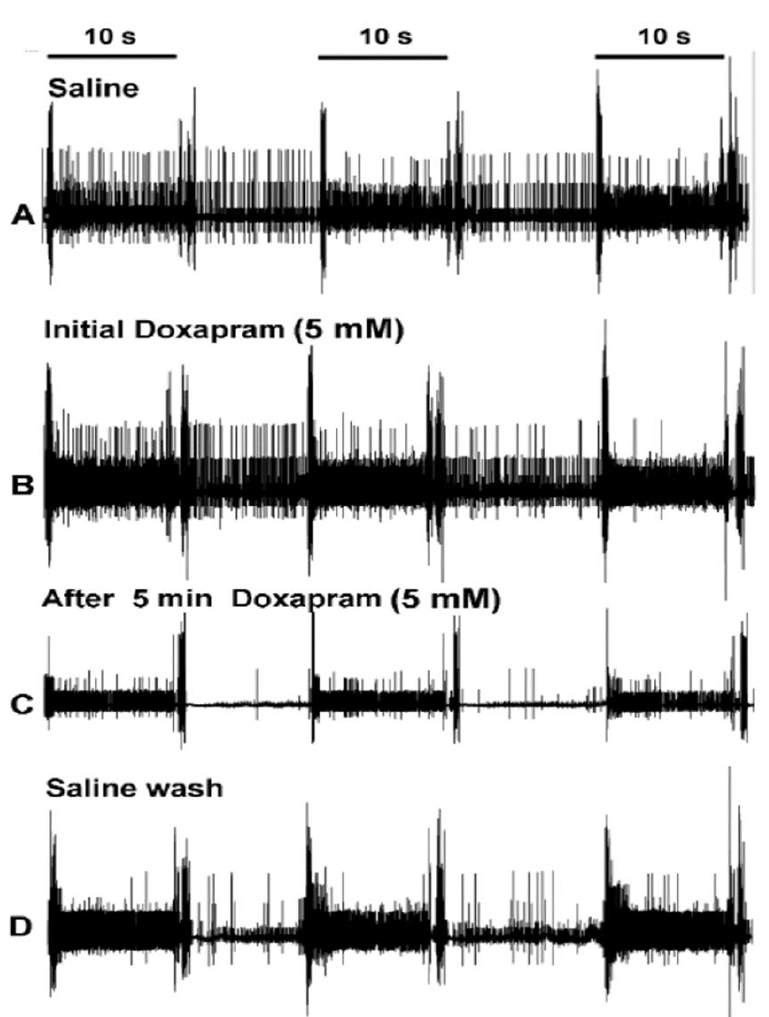
Figure 2. Representation of the effects of doxapram at 5 mM on neural activity for the proprioceptive neurons in the crab PD organ. ( A ) The activity of the nerve in saline with the three movements of the joint (1 s for the movement to an extended position and 9 s or more for being held in a static position of joint extension). ( B ) After the bath is exchanged to doxapram, the joint is then moved again three times. ( C ) Flushing the doxapram solution around the preparation and allowing it to incubate for 5 min. After 5 min, three more movements are made. ( D ) The bath is exchanged two times with fresh saline and the joint movements are repeated. Only the initial 10 s are used for analysis.